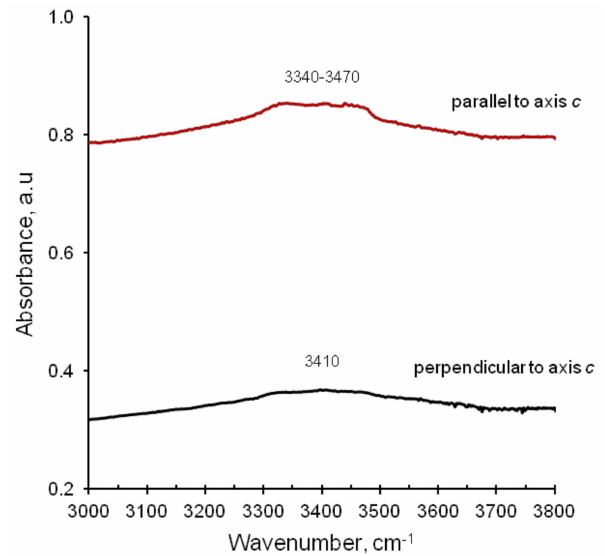
Figure 11. FTIR oriented spectra of rippite in the 3000–3800 cm − 1 range (single crystal on KBr